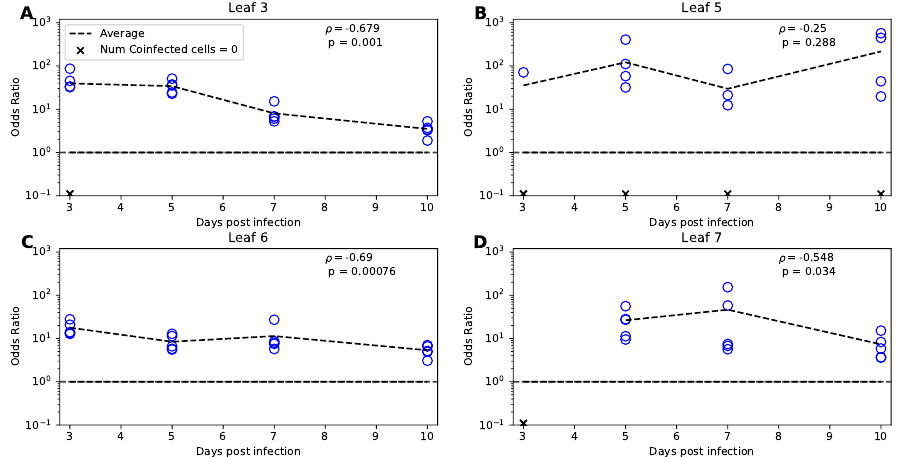
Figure 5. There is a high degree of coinfection of individual leaf cells by two different viruses. For each leaf we calculated the odds ratio (the relative probability of a cell being coinfected by two different viruses as compared to infection rate of cells by individual viruses, Equation (41)) using a previously published method [33]. Note that when infection proceeds randomly, the expected odds ratio is 1. Resulting odds ratio for individual plants are shown for leaf 3 ( A ), leaf 5 ( B ), leaf 6 ( C ), and leaf 7 ( D ); lines connect the average values per time point. Missing values (when odds ratio could not be calculated) are denoted as crosses. Spearman-rank correlations ρ of the change in odds ratio with time per leaf and p -values from the test ( ρ = 0) are shown on individual panels (when calculating ρ missing values were